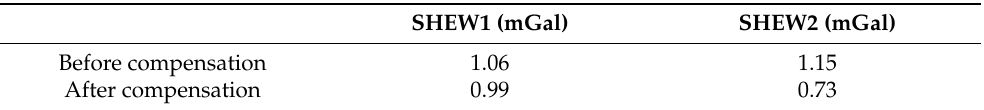
Table 2. Statistics of gravity-measurement accuracy of repeated survey lines before and after com- pensation (300 s filtering).